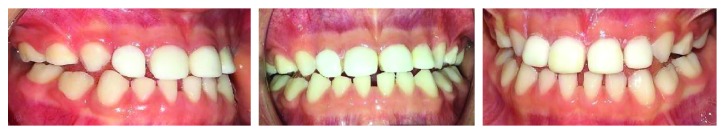
Three-month posttreatment intraoral photo.